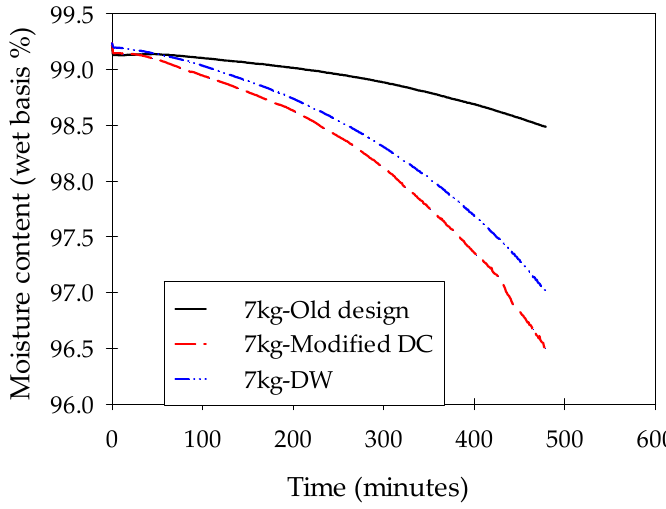
Figure 10. Variation in the moisture content at the maximum test load.